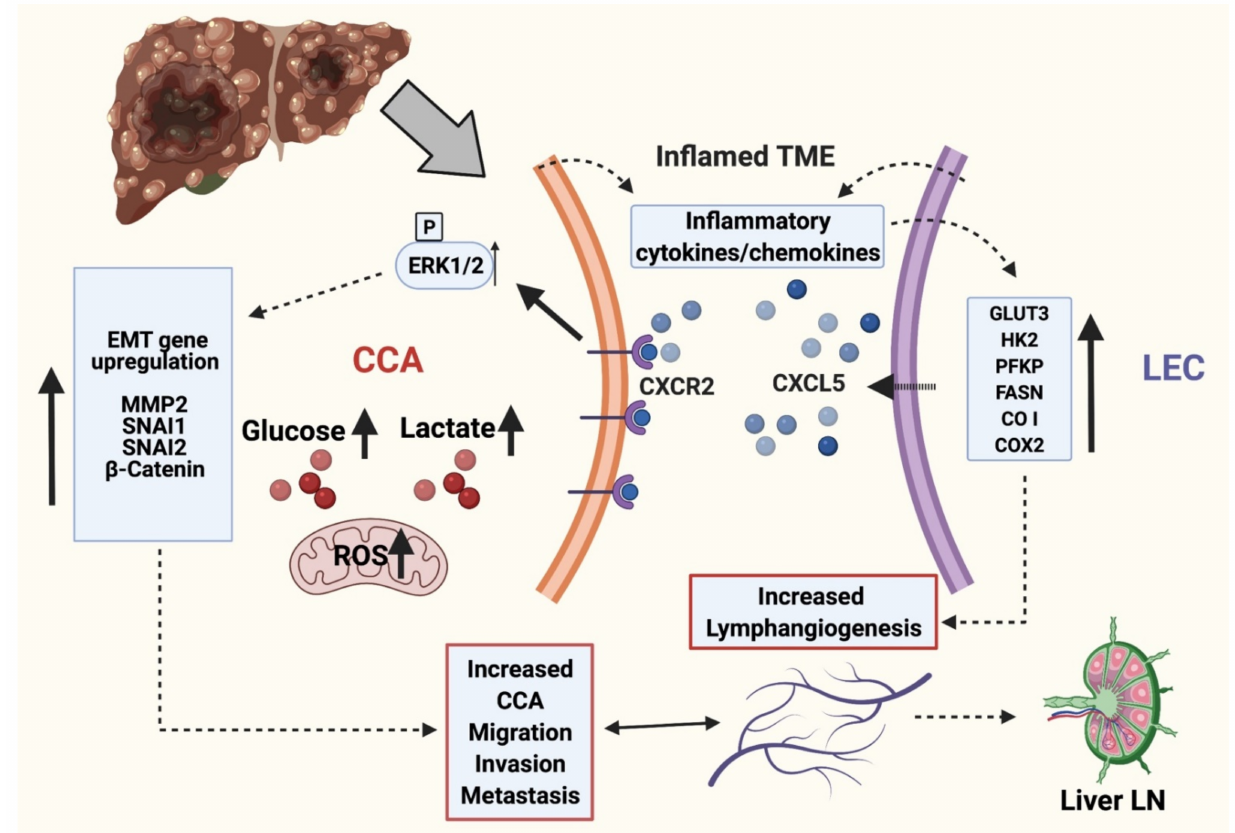
Figure 7. Working model of molecular interplay between LEC and CCA during CCA progression. LECs and CCA cells in inflamed TME actively produce several cytokines and chemokines. CXCL5 produced by inflamed LECs interacts with CXCR2 in CCA cells and potentiates EMT, matrix remodeling and alters cellular metabolism. The proinflammatory cytokines and chemokines in the TME in turn induces metabolic alterations in LECs resulting in ATP generation and activation of lymphangiogenesis. This signaling axis potentiates CCA LN metastasis. Thus CXCL5-CXCR2 crosstalk between LECs and CCA cells in inflamed environment results in aiding the lymphatic metastasis of CCA cells. (This schematic was created with BioRender.com accessed on 25 October